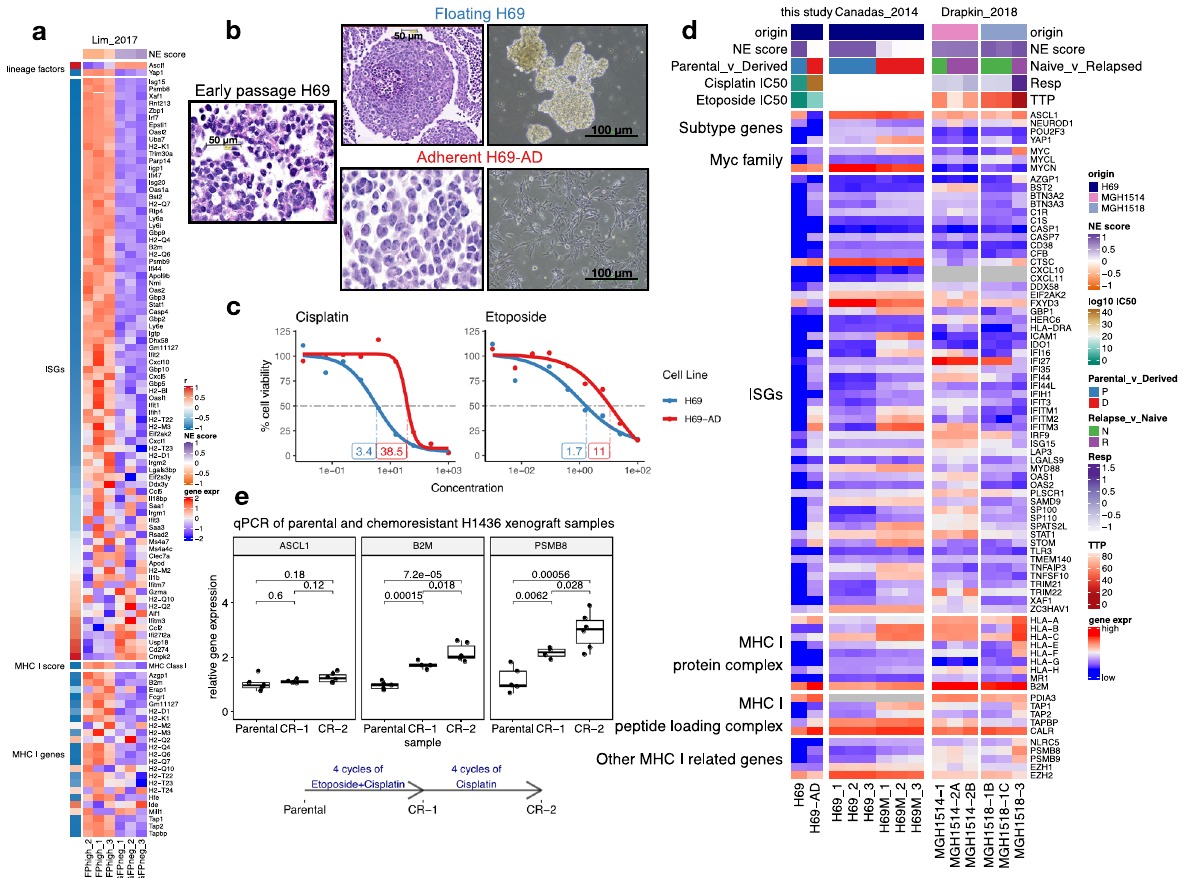
Fig. 6 MHC I upregulation in chemoresistant SCLC. a Heatmap visualizing increased expression of ISGs, MHC I genes as cells switch from Ascl1 + to Yap1 + in SCLC GEMM tumors from the “ Lim_2017 ” . GFP was expressed from an endogenous promoter of a Notch target gene Hes1 in Rb − / − / p53 − / − / p130 − / − (TKO) background. Using fl ow cytometry, the authors fi rst sorted out SCLC tumor cells and then further sorted by GFP to obtain relatively pure tumor cells with different Notch activation status. Three biological replicates were each provided for GFP negative (Notch inactive, classic high-NE) cells and GFP-positive cells (Notch-active, low-NE). b Different morphology and culture characteristics of adherent H69-AD and the parental H69. c Dose – response curves for Cisplatin and Etoposide in the H69 cell line pair. Note that H69-AD, the adherent line, is more resistant with higher IC50s. d Expression changes of selected genes in H69 cell line pair from this study, H69 and derived mesenchymal H69-M cell lines from “ Canadas_2014 ” and autologous PDX samples before and after chemotherapy from “ Drapkin_2018 ” . PDX parameters: TTP, time to progression, de fi ned by time to 2× initial tumor volume; RESP, change in tumor volume between initial tumor volume and a minimum of days 14 – 28. Relapsed sample from MGH-1514 did not show increased chemoresistance based on the RESP and TTP parameters. Note that unlike other heatmaps, due to the small number of samples in each data set, the expression is not scaled across samples in this heatmap. e qPCR measurement of normalized ASCL1 , B2M , and PSMB8 expression in naive parental and chemoresistant H1436 xenograft tumors. p -values are based on a two-sided t -test. The centerline in the boxplot represents the median, the lower and upper hinges correspond to the fi rst and third quartiles, the whiskers extend from the hinge to the value no further than 1.5 * IQR